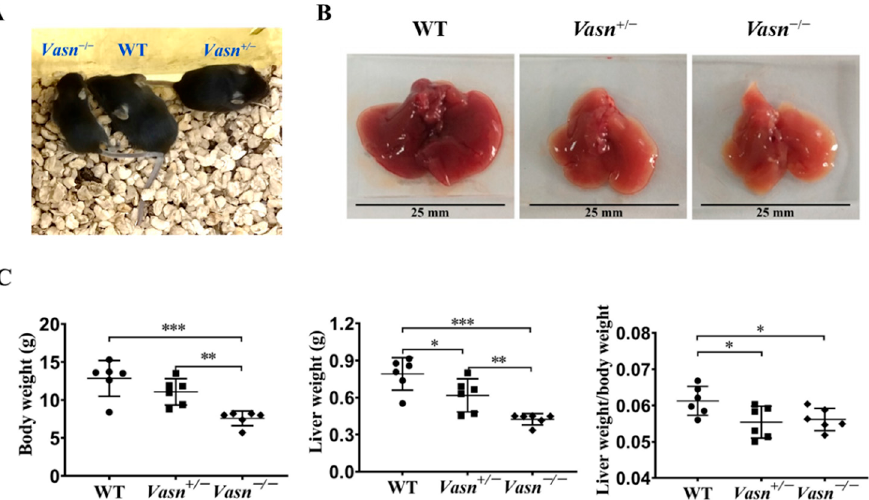
Figure 1. Liver weight/body weight loss in Vasn − / − and Vasn +/ − . ( A ) Photos of Vasn − / − , Vasn +/ − , and WT mice. ( B ) Photos of livers separated from Vasn − / − , Vasn +/ − , and WT mice. ( C ) Liver weight/body weight loss in Vasn − / − and Vasn +/ − mice. * p < 0.05, ** p < 0.01, *** p < 0.001. Data are represented as mean ± SD of six mice per group.